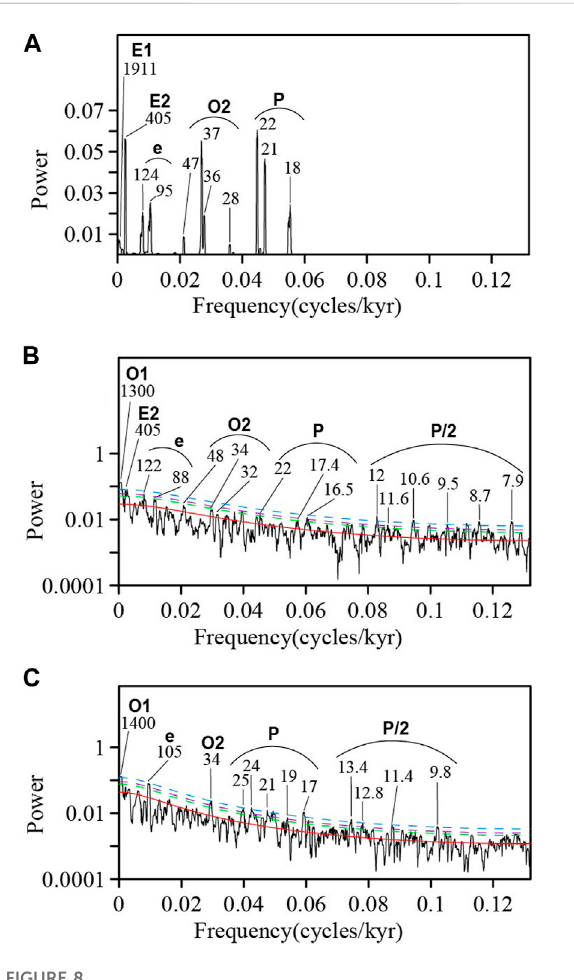
FIGURE 8 2 π MTM spectral analyses for (A) the orbital signals for the La2004 solution (Laskar et al., 2004), over the periods of 110 – 120 Ma (B) the 405-kyr tuned χ series, and (C) the 105-kyr tuned χ series. E1: the longer eccentricity (~2 Myr); E2: long eccentricity; e: short eccentricity; O1: the longer obliquity (~1.2 Myr); O2: obliquity; P: precession; P/2: